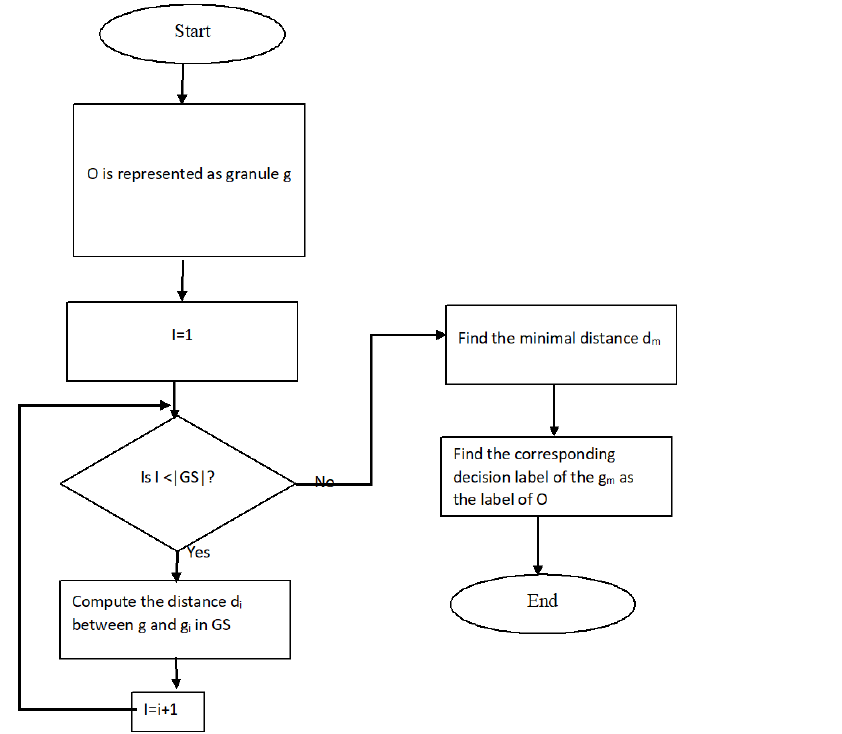
Figure 6. The Testing